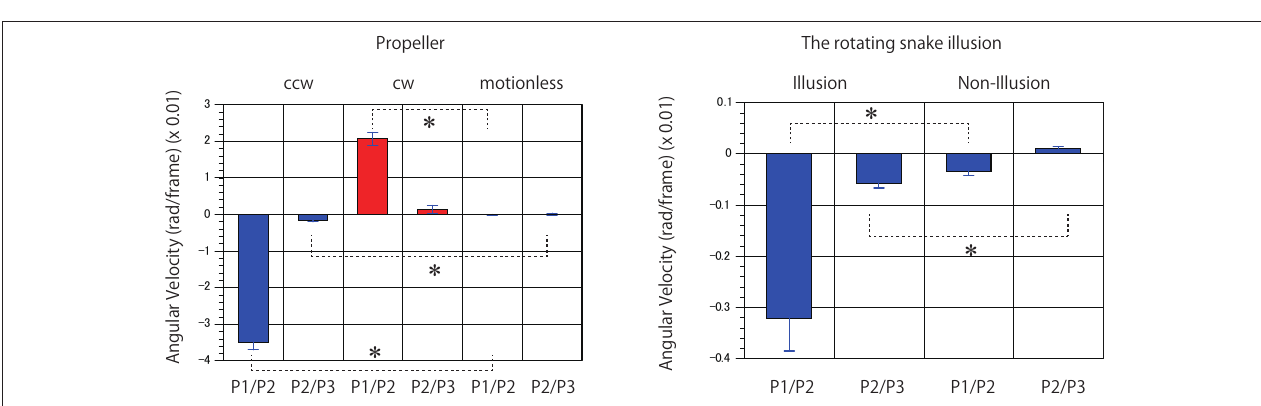
FIGURE 6 | Predicted motion detected in the rotating propellers and the illusions. Mean angular velocities derived from 400 to 1000K trained networks were averaged ( n = 7). Error bars indicate standard errors. Asterisks indicate a significant difference ( p < 0.01).